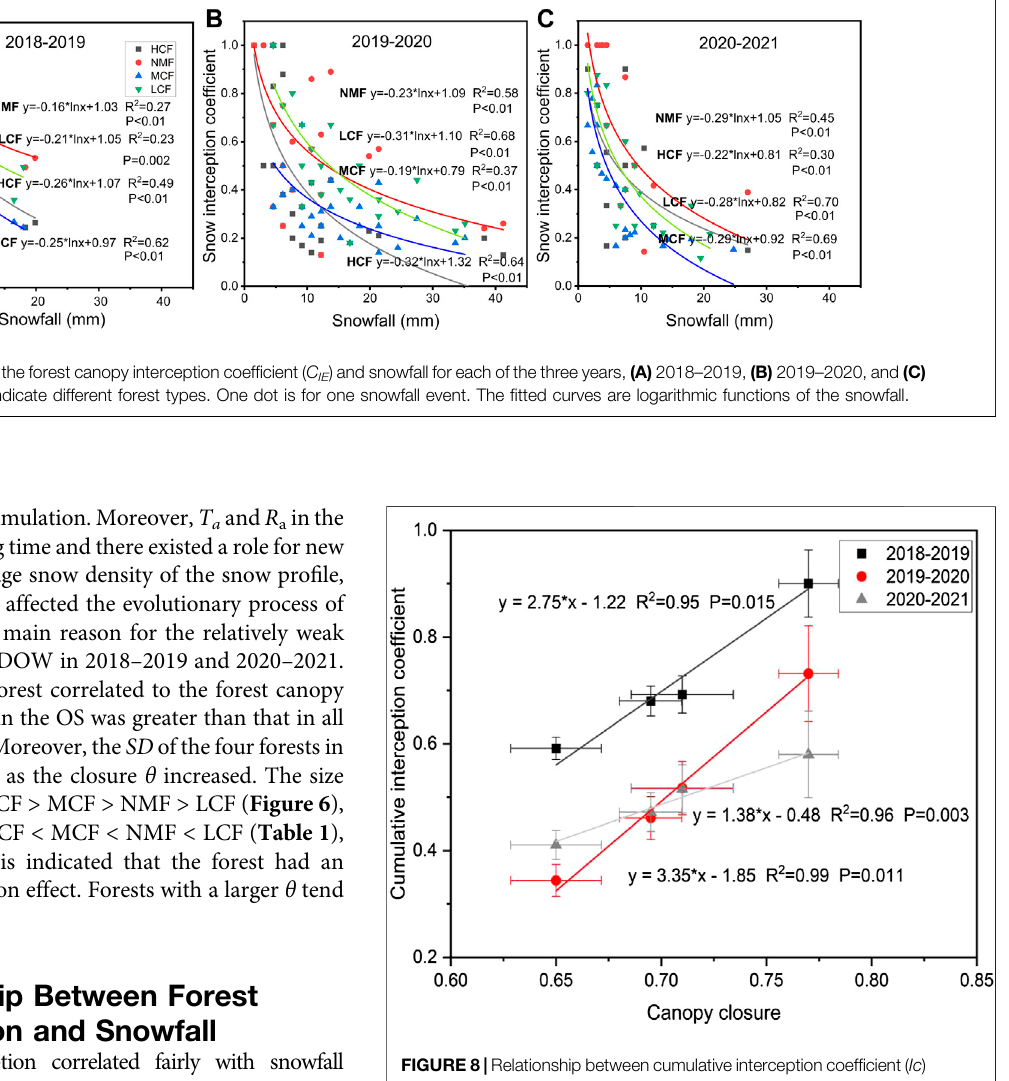
FIGURE 8| Relationship between cumulative interception coef fi cient( Ic ) and forest canopy closure ( θ ). Points with different colors and shapes represent different years: the black square points represent 2018 – 2019, the red points represent 2019 – 2020, and the gray triangle points represent 2020 –